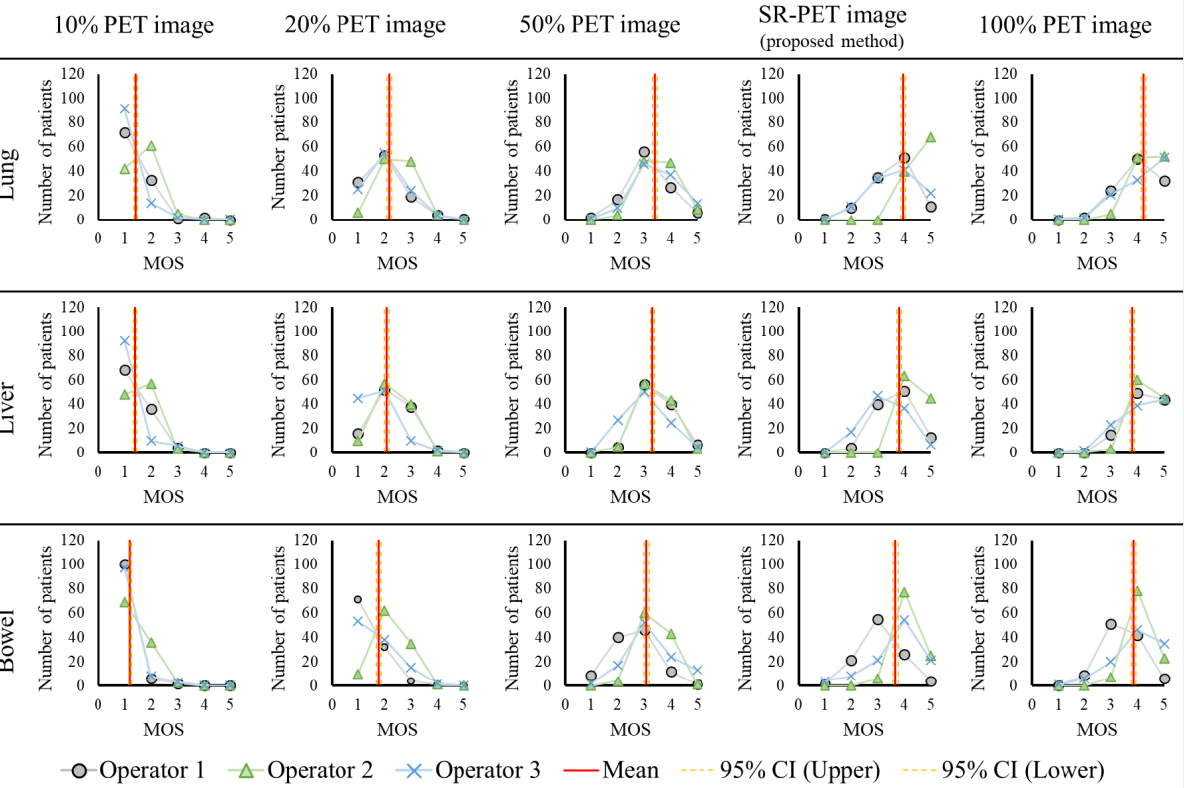
Figure 3. Subjective evaluation results of the MOS in each image set. PET: Positron emission tomog- raphy, SR-PET: Supe-resolved PET, MOS: Mean opinion score, and 95% CI: 95% confident interval.